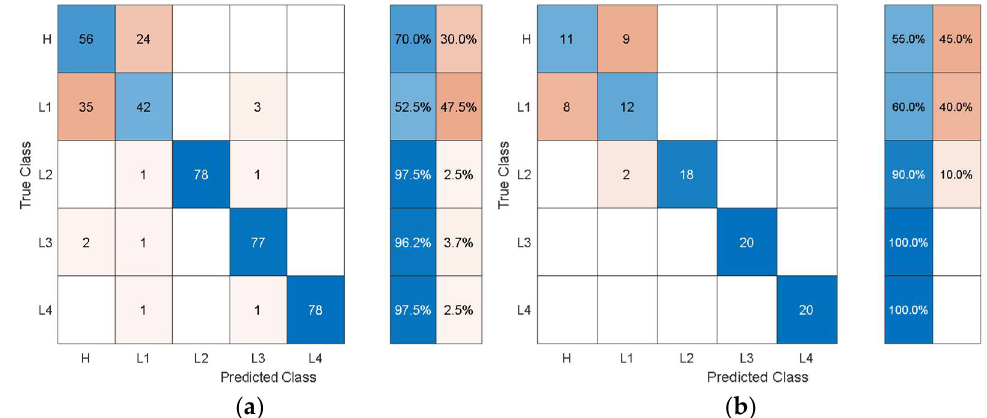
Figure 9. Classification performance of SVM using the autonomous features from the 23rd layer of AlexNet in terms of its confusion matrices: ( a ) training; ( b ) test.